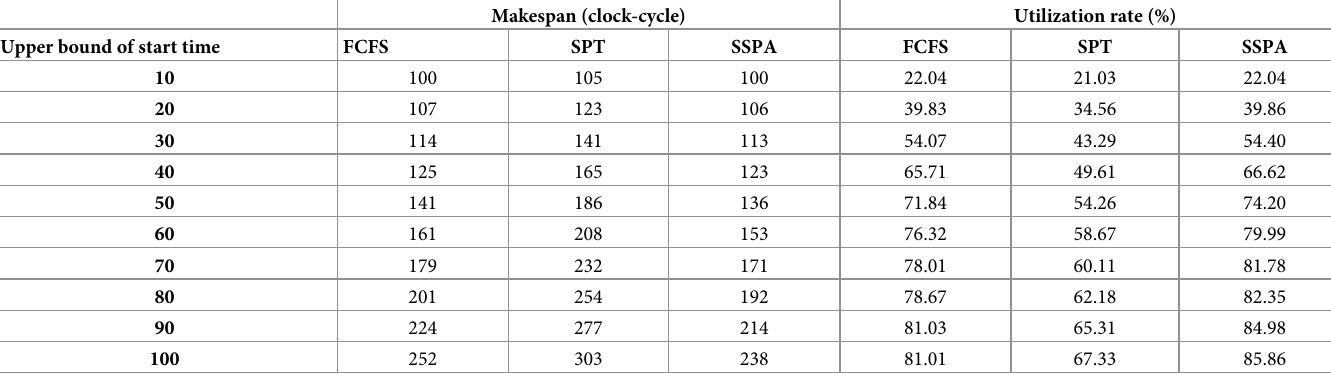
Table 3. Results for variable start time. Makespan (clock-cycle) Utilization rate